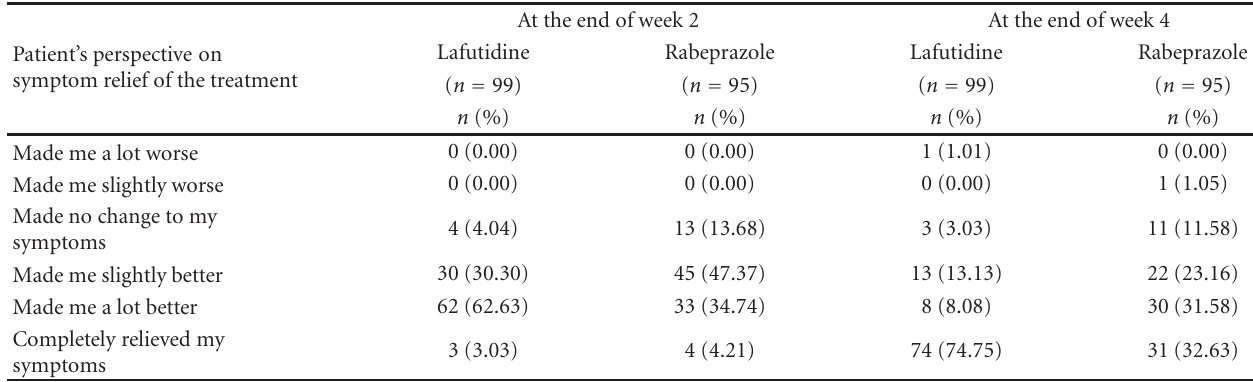
Table 4: Frequency distribution of “patient’s perspective on symptom relief” survey responses.